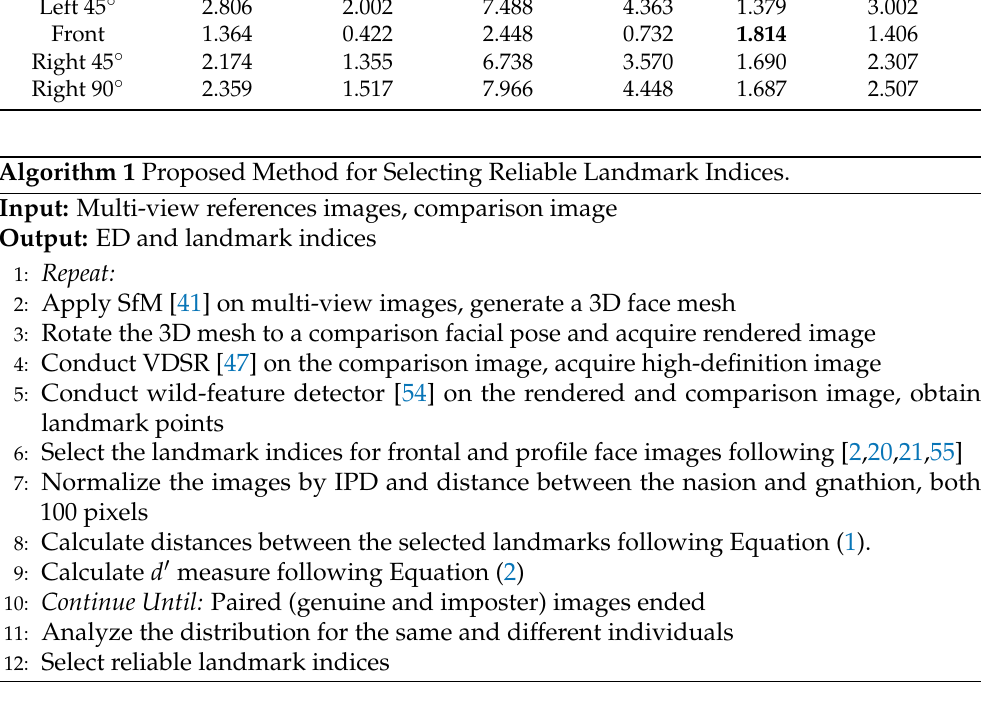
Algorithm 1 Proposed Method for Selecting Reliable Landmark